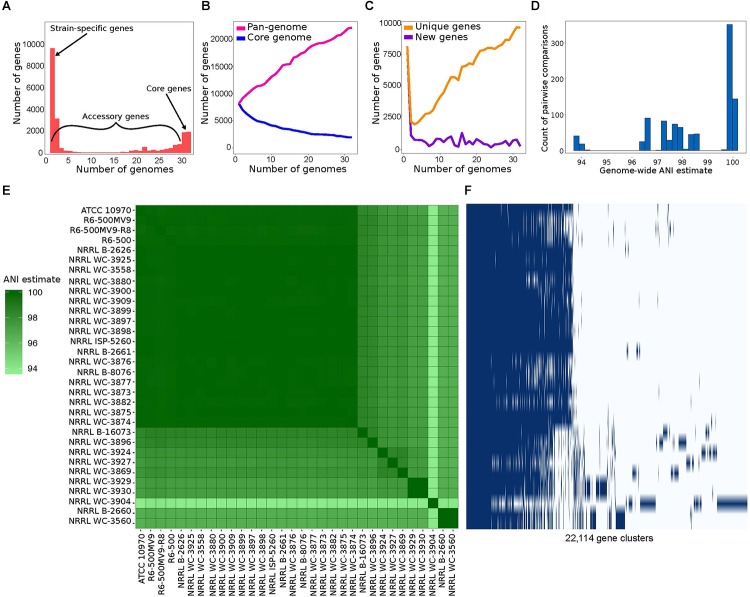
Pan-genome analysis of 32 Streptomyces rimosus strains. (A) The number of unique genes that are shared by any given number of genomes or unique to a single genome. Numerical values for each gene category are shown in Supplementary Table S2. (B) The size of the core genome, i.e., genes that are present in at least 31 of the 32 strains (blue line) and pan-genome, i.e., the totality of unique genes present in the population (pink line) in relation to numbers of genomes compared. The list of core genes is listed in Supplementary Table S3. (C) The number of unique genes, i.e., genes unique to individual strains (yellow line) and new genes, i.e., genes not found in the previously compared genomes (purple line) in relation to numbers of genomes compared. (D) Distribution of pairwise average nucleotide identity (ANI) values. ANI calculates the average nucleotide identity of all orthologous genes shared between any two genomes. The 95% ANI cutoff is a frequently used standard for species demarcation. (E) Pairwise whole genome ANI comparison. Percentage values are shown in Supplementary Table S4. (F) Gene presence-absence matrix showing the distribution of genes present in a genome. Each row corresponds to a strain in panel E. Each column represents an orthologous gene family. Dark blue blocks represent the presence of a gene, while light blue blocks represent the absence of a gene.